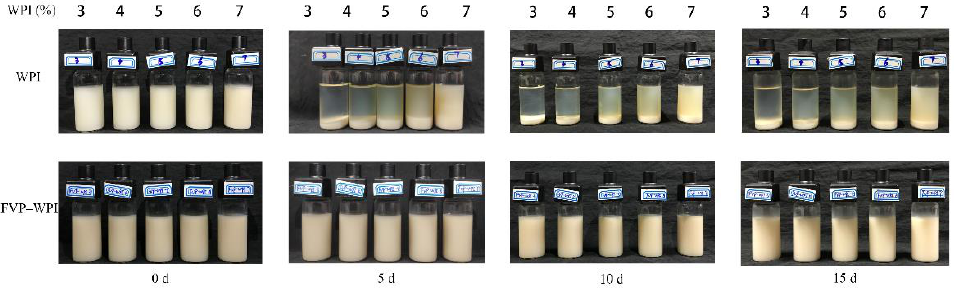
Figure 2. Images of WPI and FVP–WPI solutions over 15 d of storage.